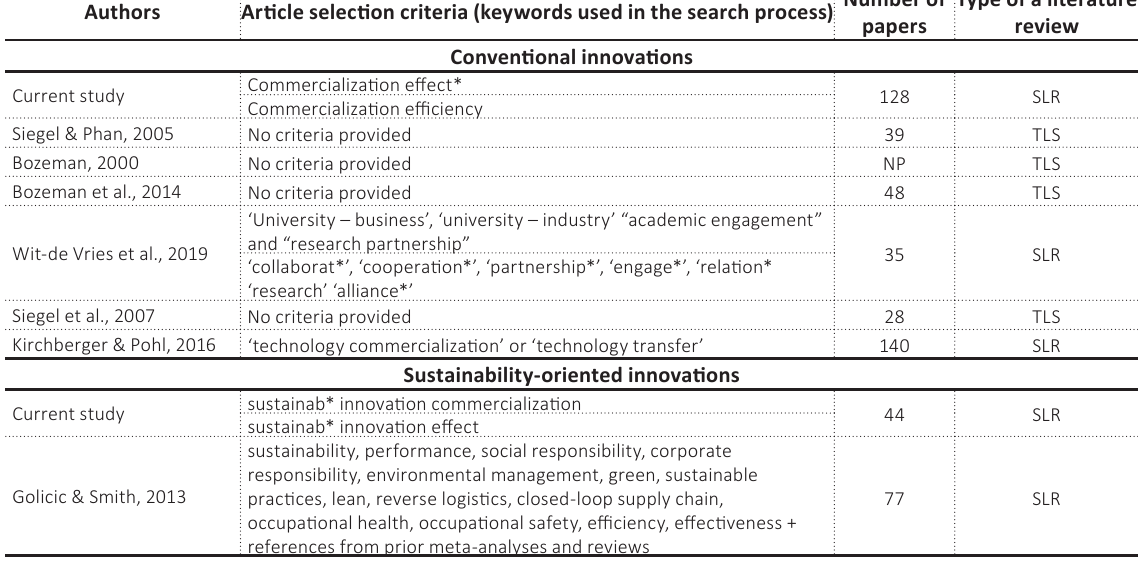
Source: Compiled by the